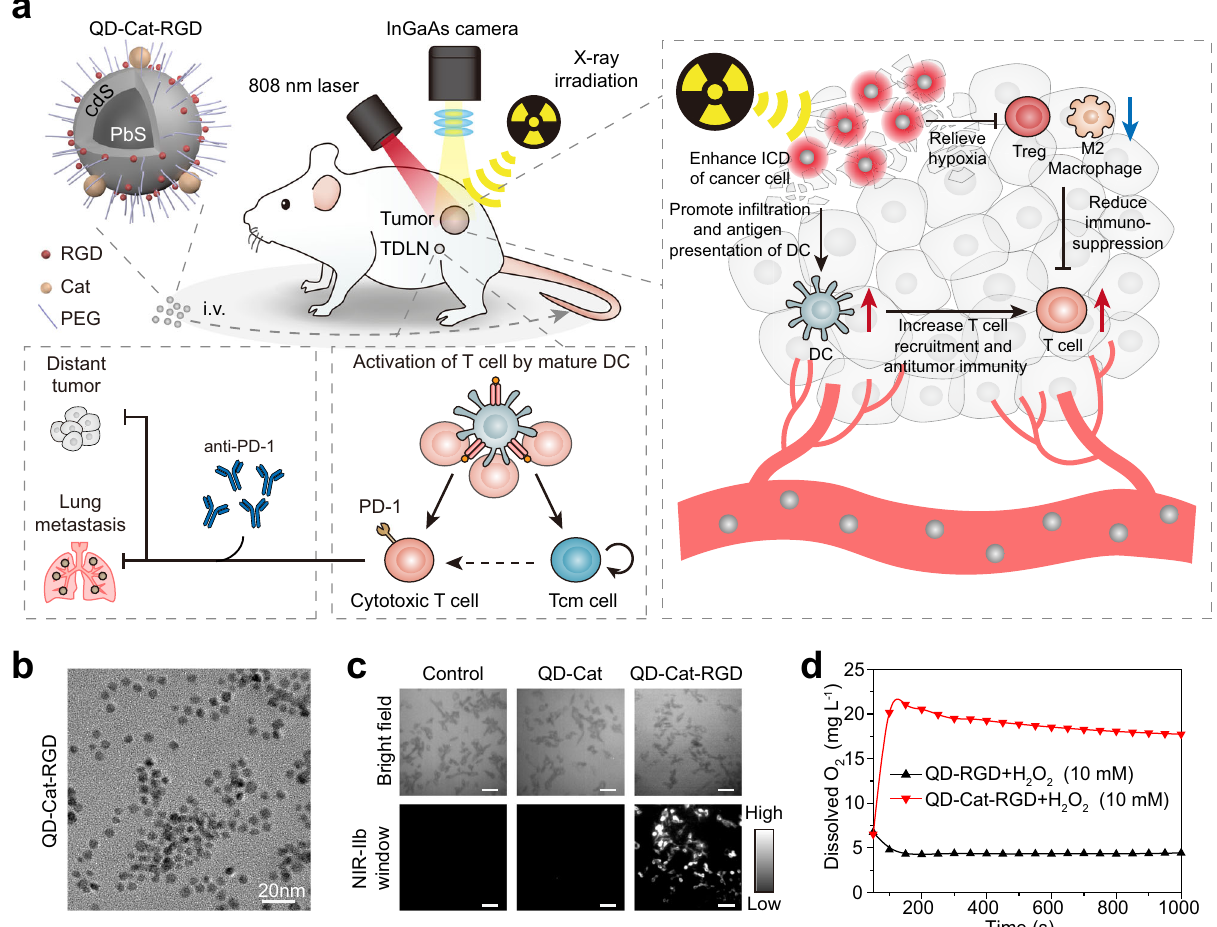
Fig. 1 Schematic and characterization of QD-Cat-RGD. a Schematic showing the mechanism by which QD-Cat-RGD nanoprobe-based RT boosts the antitumor immune response and abscopal effect to inhibit cancer metastases. b A TEM image of QD-Cat-RGD nanoprobes. Scale bar = 20 nm. c Images of 4T1 cells after incubation with PBS (control), QD-Cat (without RGD modi fi cation), or QD-Cat-RGD (with RGD modi fi cation) in the NIR-IIb window and bright fi eld. Scale bars = 50 μ m. d Dissolved oxygen generation in H 2 O 2 solutions (10 mM) with QD-RGD (without Cat modi fi cation) or QD-Cat-RGD. The TEM of the QD-Cat-RGD nanoprobe ( b ), the cell imaging experiments ( c ), and H 2 O 2 decomposition experiment ( d ) were representative of those generated from three independent experiments. RGD arginine – glycine – aspartate peptides, Cat catalase, PEG poly(ethylene glycol), ICD immunogenic cell death, Treg regulatory T cell, DC dendritic cell, Tcm central memory T cell, i.v. intravenous, PD-1 programmed cell death 1, TDLN tumor-draining lymph node, NIR-IIb near-infrared IIb. Source data are provided as a Source Data fi